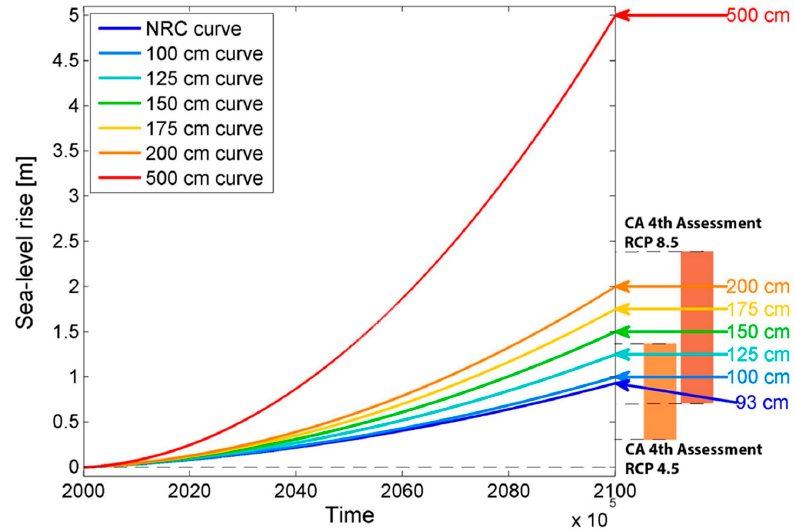
Figure 4. SLR curves used for the cliff retreat and shoreline change models (modified from [51]). Bands (right side) illustrate the range of SLR projections at 2100 from the 4th California Climate Assessment